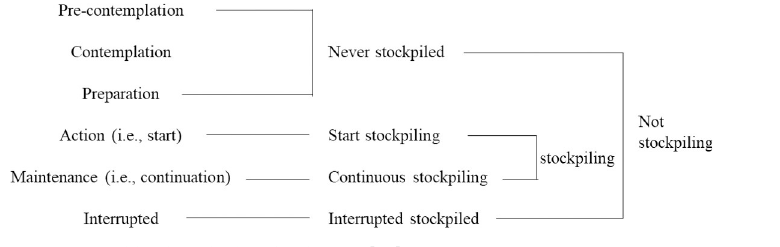
Fig 1. Stage of food stockpiling for disaster